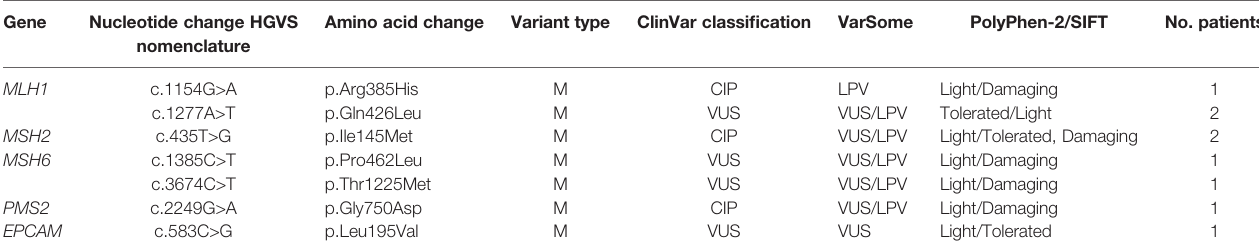
TABLE 3 | Germline MMR variants of uncertain signi fi cance detected in LS-related CRC patients. Gene Nucleotide change HGVS